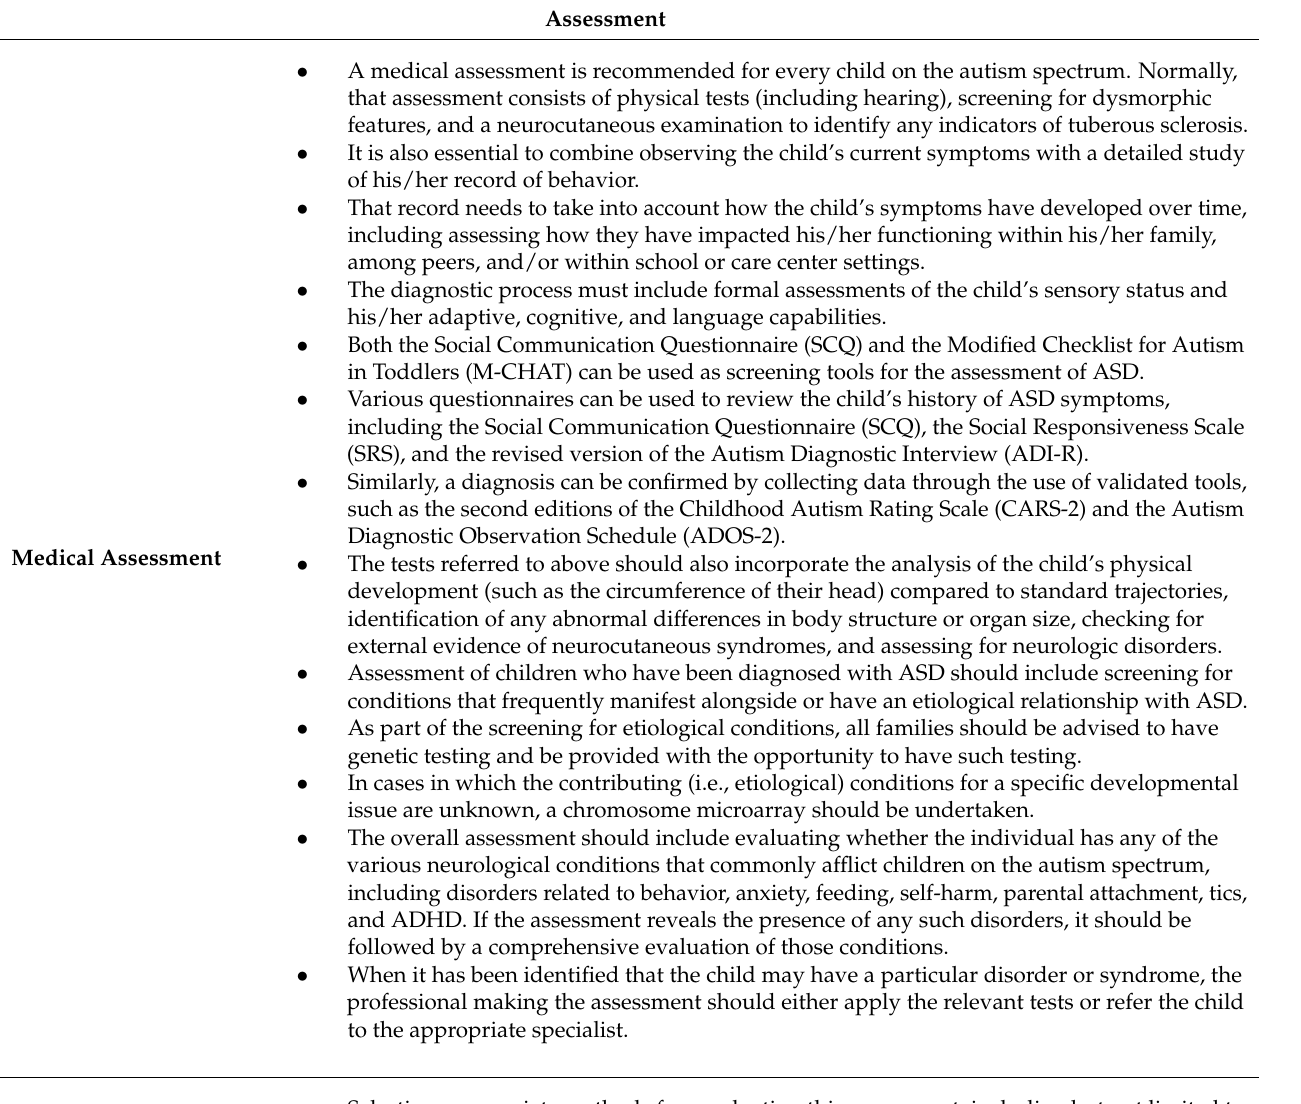
Table 2. Recommendations for